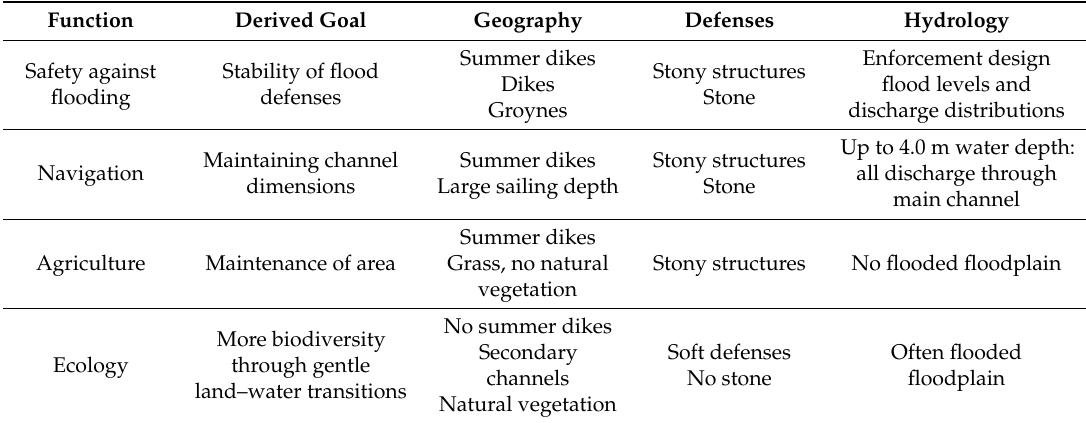
Table 2. Sectoral wishes with regard to